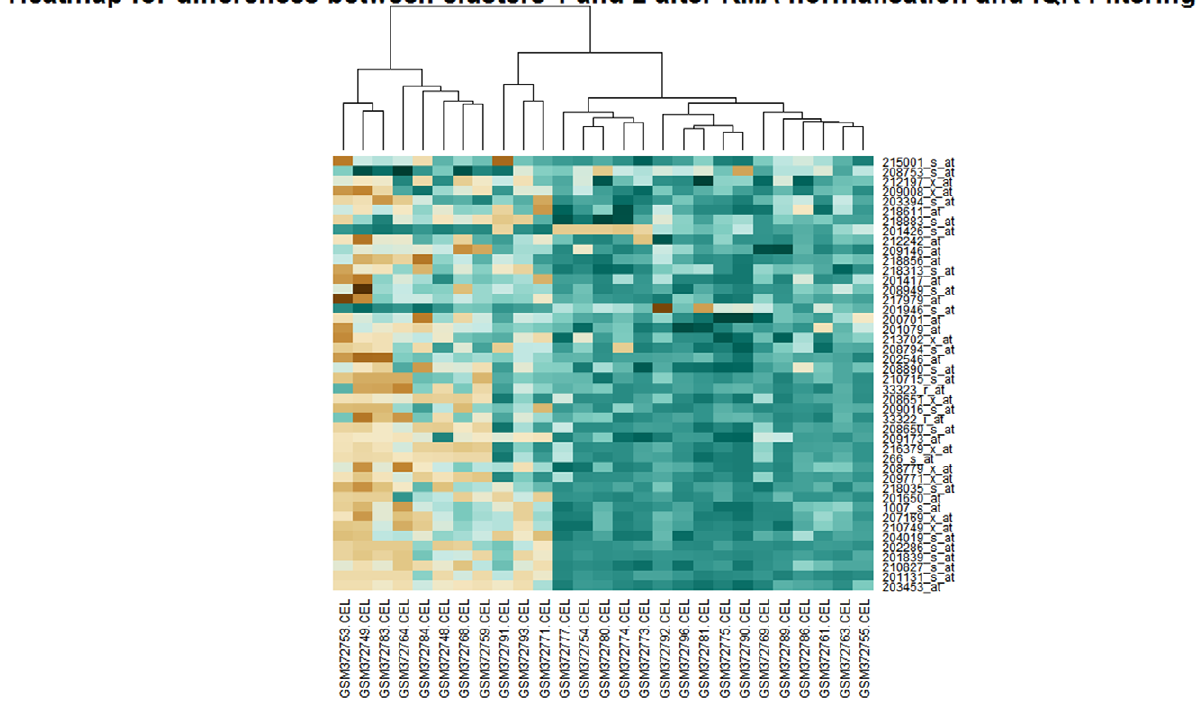
Figure 3. Heatmap for the differentially expressed genes between clusters 1 and 2 for the rma normalised data filtered using the IQR method to give 1025 probes.